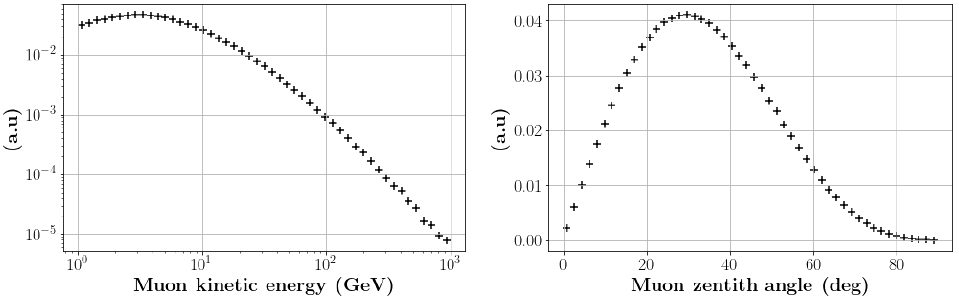
Figure 8. Example of simulated muon energy distribution ( left ) and zenith angle distributions ( right ). Units are